Question: In one sentence, what is this figure communicating?
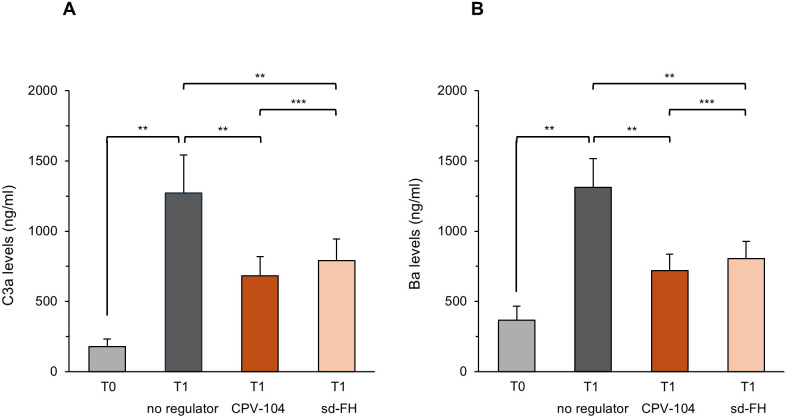
Answer: Effect of CPV-104 on complement activation in fluid phase. (A–B) C3 convertase activity and formation in sera from eight NeF positive C3G patients were assessed by measuring C3a (A) and Ba (B) release at baseline (T0) and after incubation (T1) in the absence (no regulator) or presence of 40 μg/ml CPV-104 or sd-FH. Bars represent mean ± SEM (n = 8). Statistical significance was assessed using paired t-test. *** P < 0.05; ** P < 0.01.